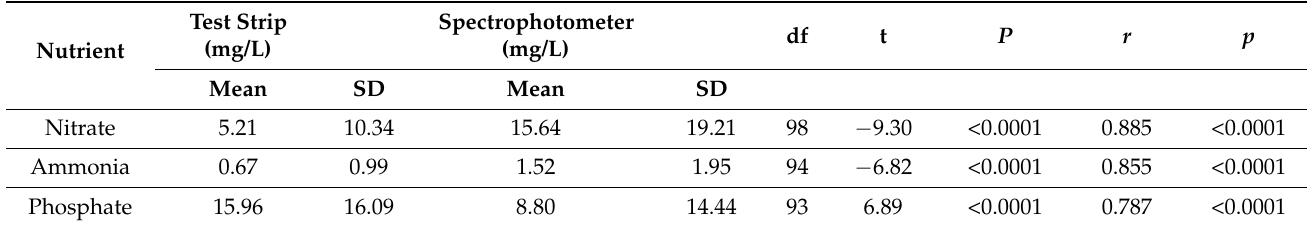
Table 2. Mean (SD) nitrate, ammonia, and phosphate concentrations of water-filled urban containers as measured by the two methods, AquaChek Test Strips and a Hach DR3800 spectrophotometer. Differences and correlations between values from the two methods were tested using paired t -tests and Pearson correlations,